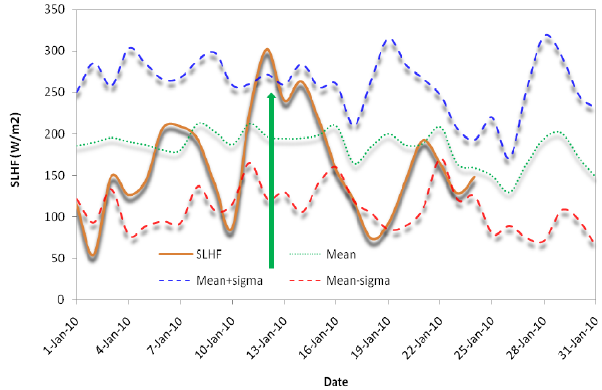
Fig. 4b. Figure 4b shows variation of daily surface latent heat flux. A maxima peak in surface latent heat flux is observed one day prior to the main earthquake event. This peak is found to be more than mean plus one sigma (standard deviation), Mean value is shown in dotted green color, mean+sigma is shown in dotted blue color and mean – sigma is shown with dotted red color.